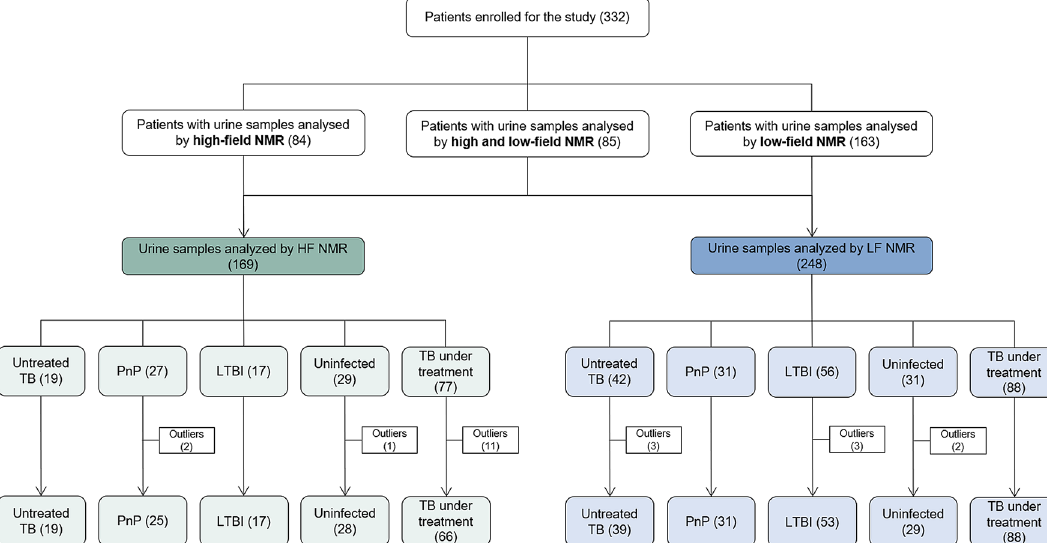
Figure 1. Description of the procedure followed to analyse the urine samples of the 332 participants by high and/or low NMR. NMR, Nuclear Magnetic Resonance; TB, tuberculosis; PnP, pneumococcal pneumonia; LTBI, latent TB infection; uninfected, individuals without